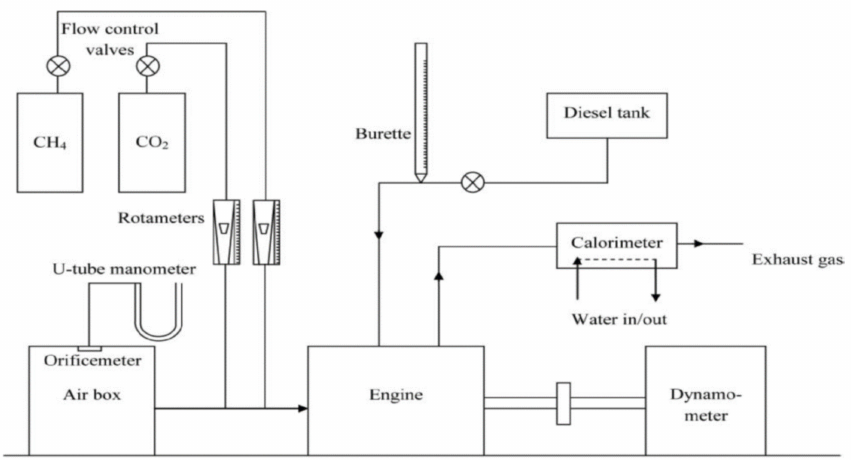
Figure 1. Experimental testing